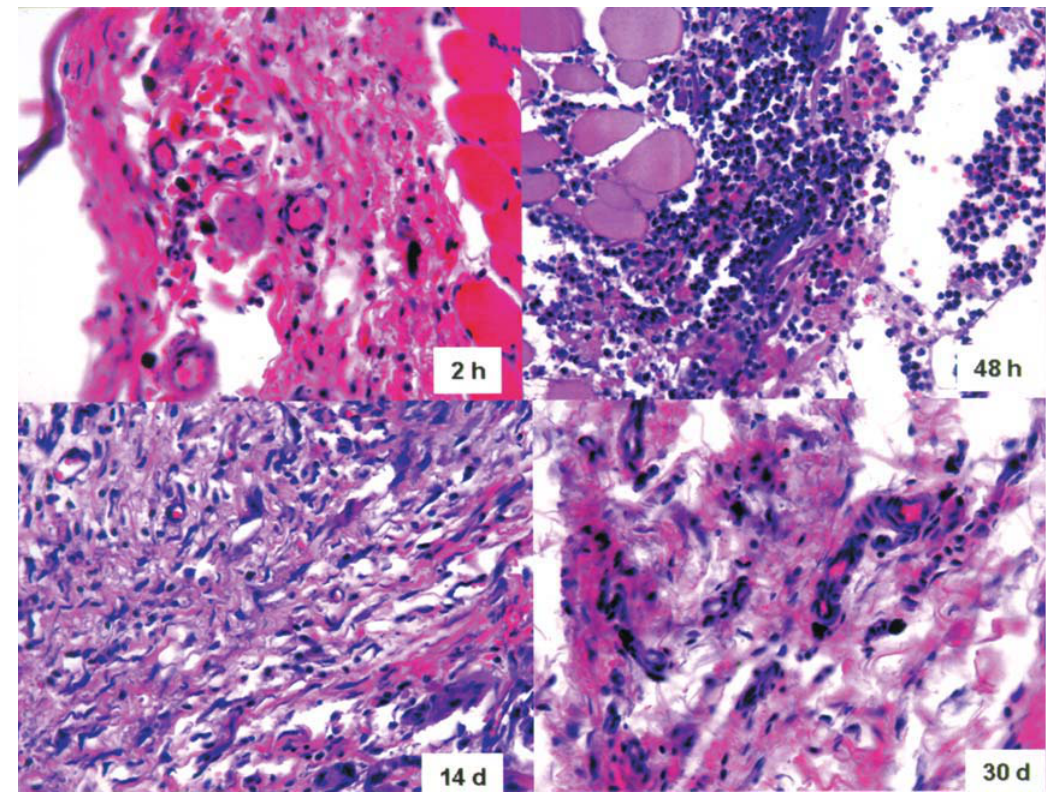
FIGURE 3 - Reaction of rat subcutaneous connective tissue to 2.5% NaOCl (H.E.; x25)